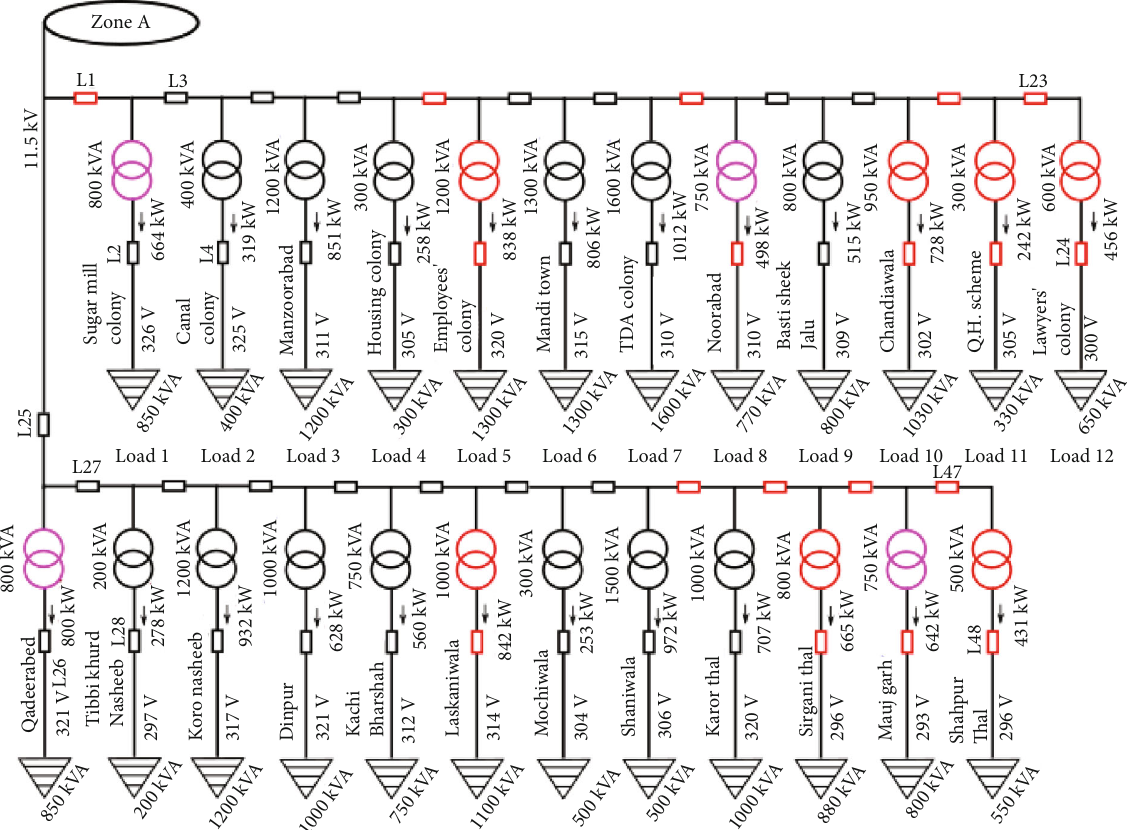
Figure 8: Implementation of zone A of the existing system on